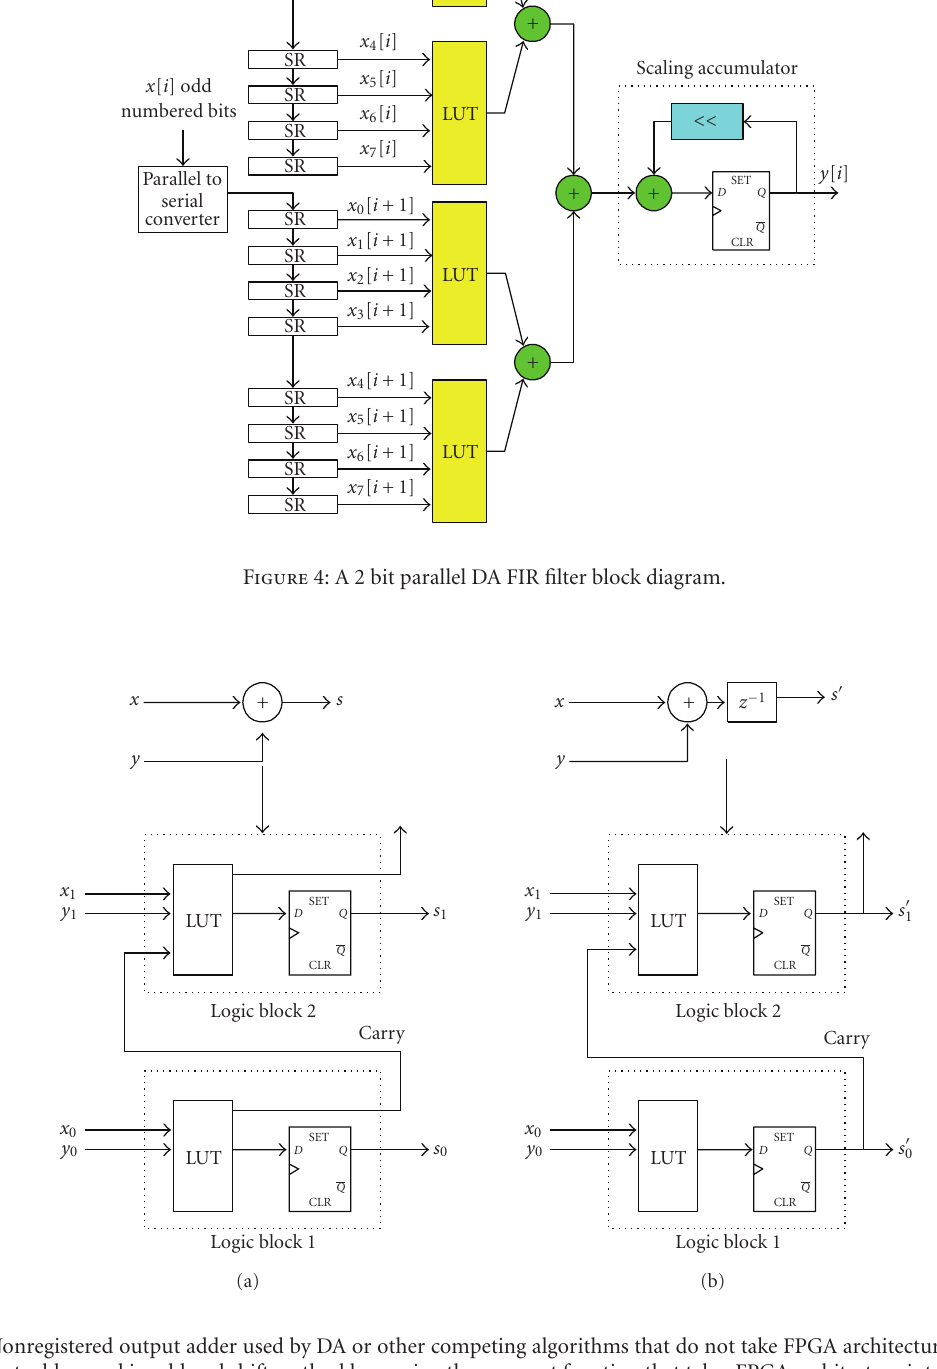
Figure 5: (a) Nonregistered output adder used by DA or other competing algorithms that do not take FPGA architecture into account. (b) Registered output adder used in add and shift method leveraging the new cost function that takes FPGA architecture into